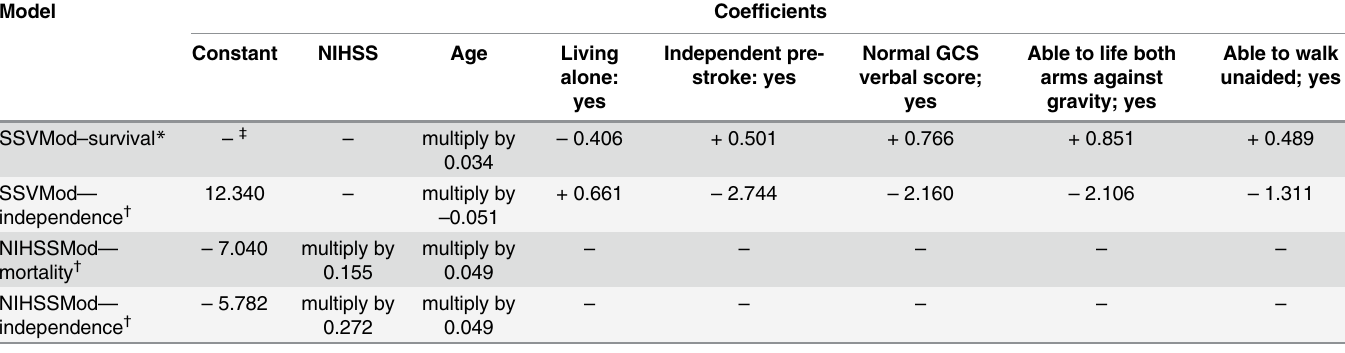
Table 1. Details of the original predictive models [9,11].